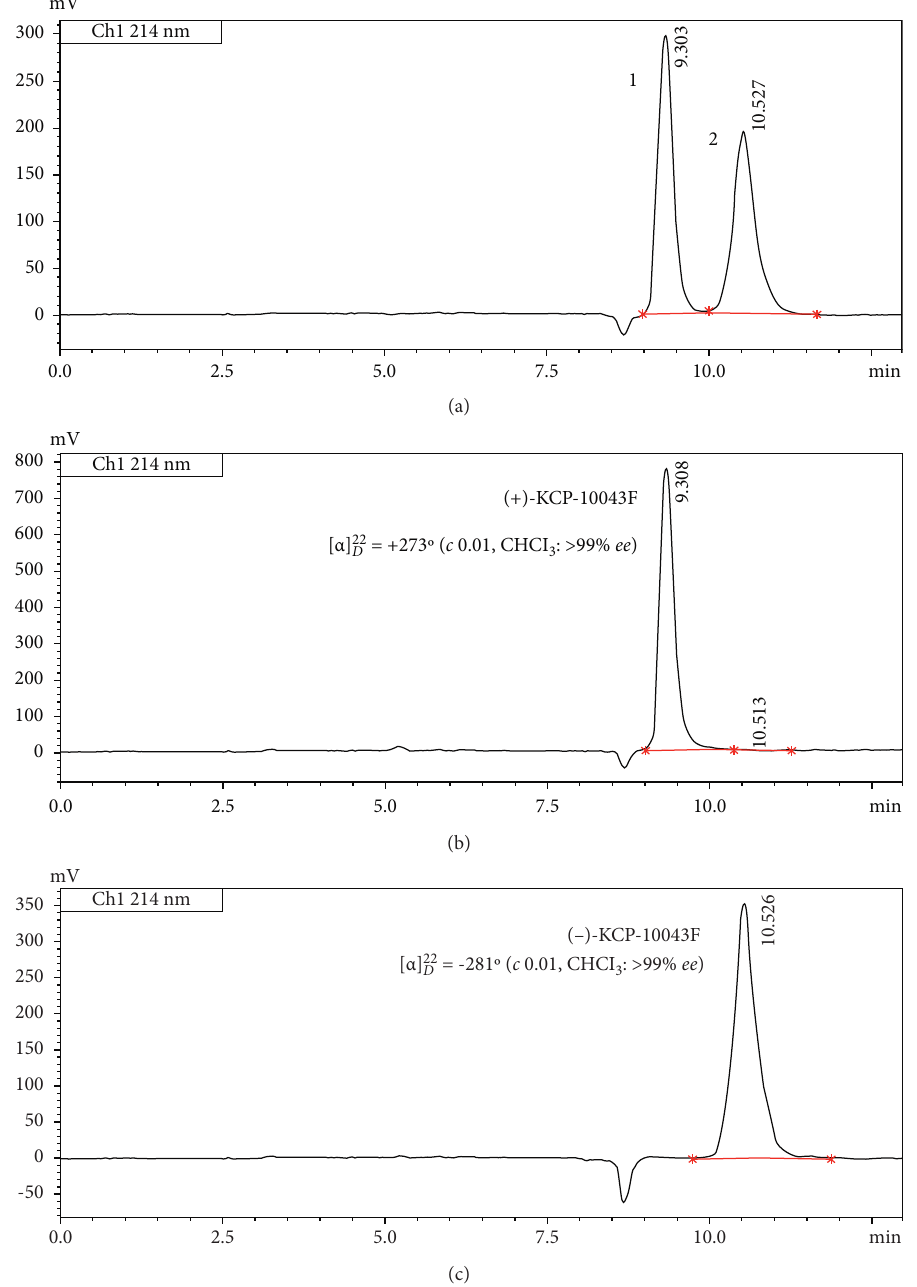
Figure 2: Chiral HPLC spectra, specific optical rotations, and enantiomeric excess ( ee ) of the racemate ( ± )- KCP-10043F ( OZ-001 ) and its two enantiomers: (a) racemate ( ± )- KCP-10043F ( OZ-001) ; (b) (+)- KCP-10043F ; (c) ( − )- KCP-10043F